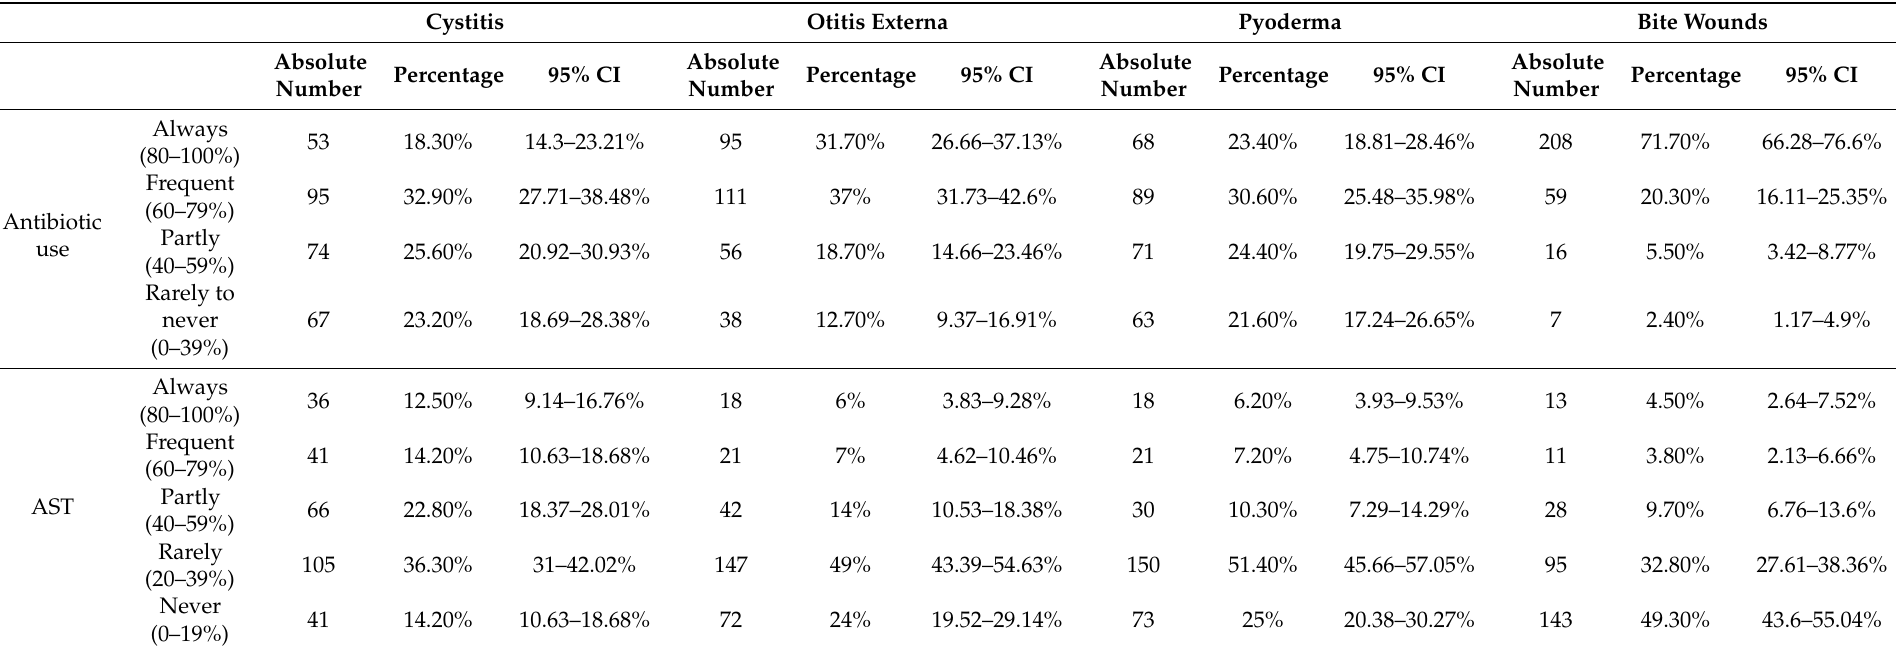
Table 2. Antibiotic use and AST. Number, percentages, and 95% CI of responses regarding the diseases of otitis externa, pyoderma, bite wounds, and cystitis according to the frequency of antibiotic use and AST. For this evaluation, 300 questionnaires for otitis externa, 292 for pyoderma, 290 for bite wounds, and 289 for cystitis were analyzed from a survey among German